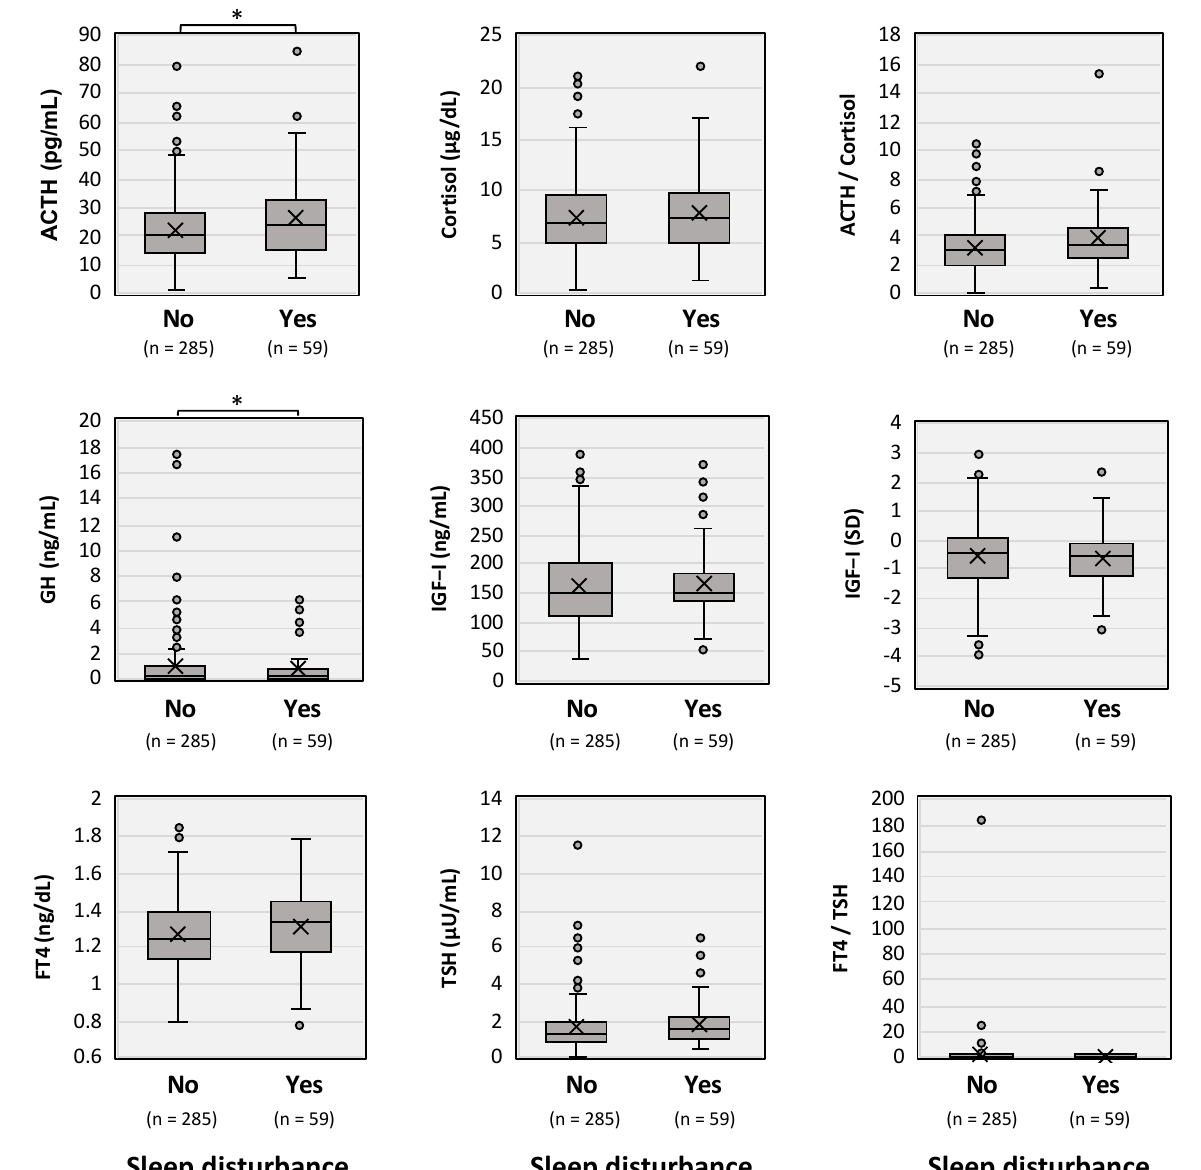
Figure 4. Hormonal trends in long COVID patients with sleep disturbance and those without sleep disturbance. Circulating levels of adrenocorticotropin (ACTH), cortisol, growth hormone (GH), insulin-like growth factor (IGF)-I, free thyroxin (FT4), and thyrotropin (TSH) were shown on the long COVID patients with (Yes) and those without (No) sleep disturbance. The upper horizontal line of the box: the 75th percentile; the lower horizontal line of the box: the 25th percentile; the horizontal bar within the box: the median; the upper horizontal bar outside the box: the maximum value within 1.5-times the interquartile range; and the lower horizontal bar outside the box: the minimum value within 1.5-times the interquartile range. The Mann–Whitney U test was performed and * p < 0.05 indicated a statistically significant difference between the indicated groups.